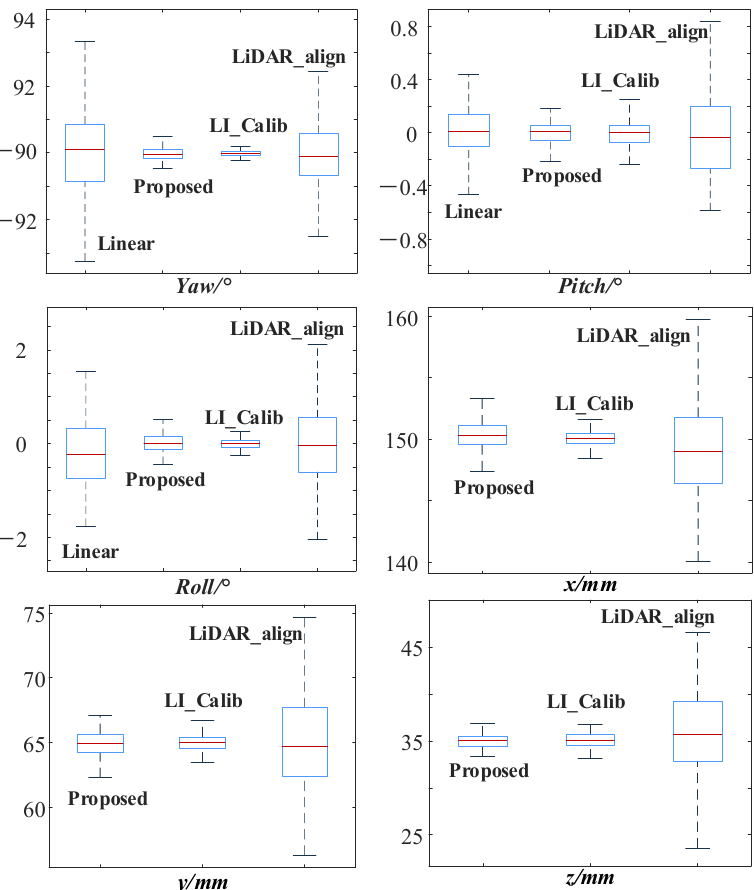
Figure 10. Calibration results of external parameters of IMU and LiDAR.